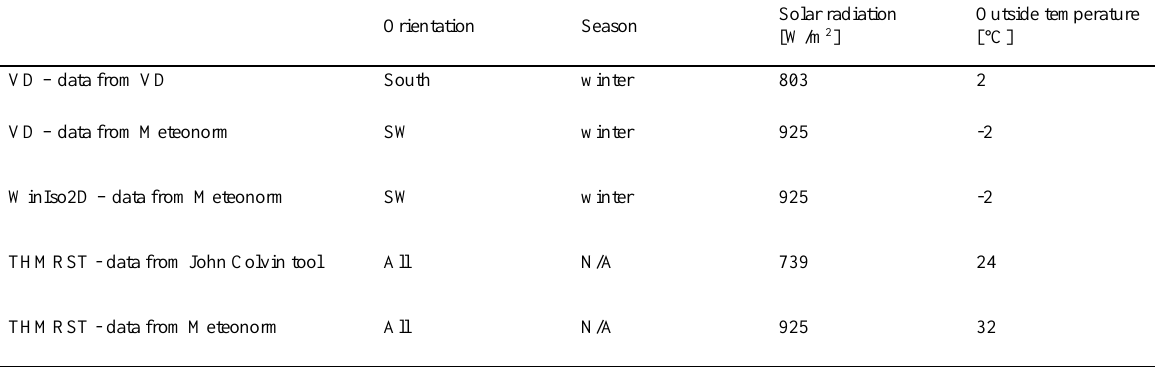
Table 5: THE MOST CRITICAL CLIMATIC DATA FOR PANE 1 for max. ∆ T